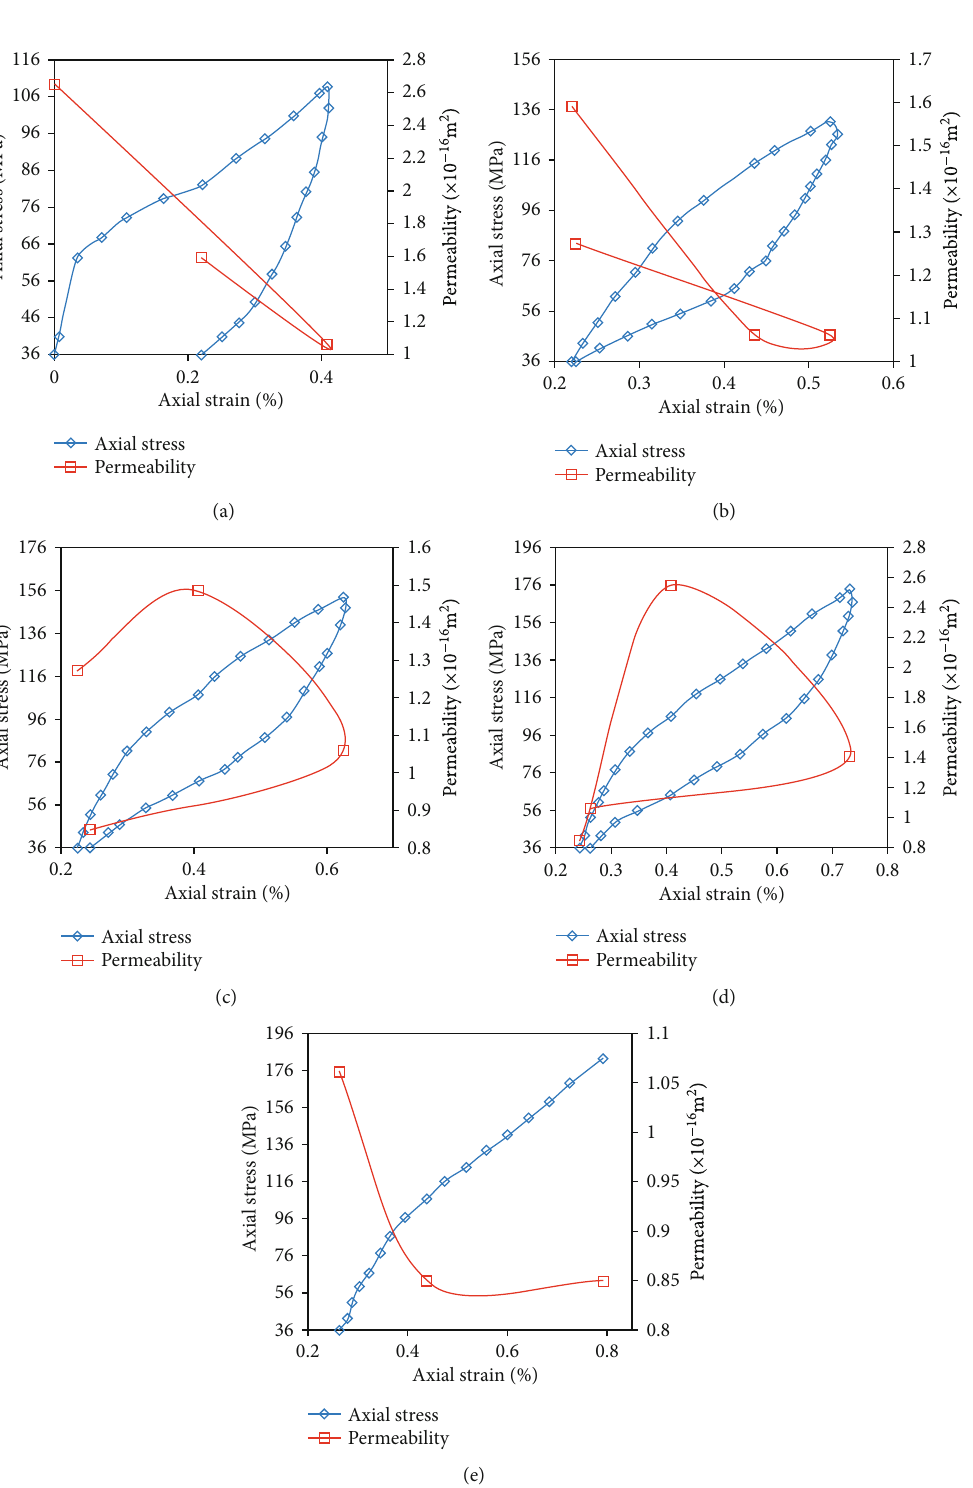
Figure 8: Stress-strain and permeability-strain curves for single-fracture sandstone at di ff erent cycles: (a) the fi rst cycle; (b) the second cycle; (c) the third cycle; (d) the fourth cycle; (e) the fi fth